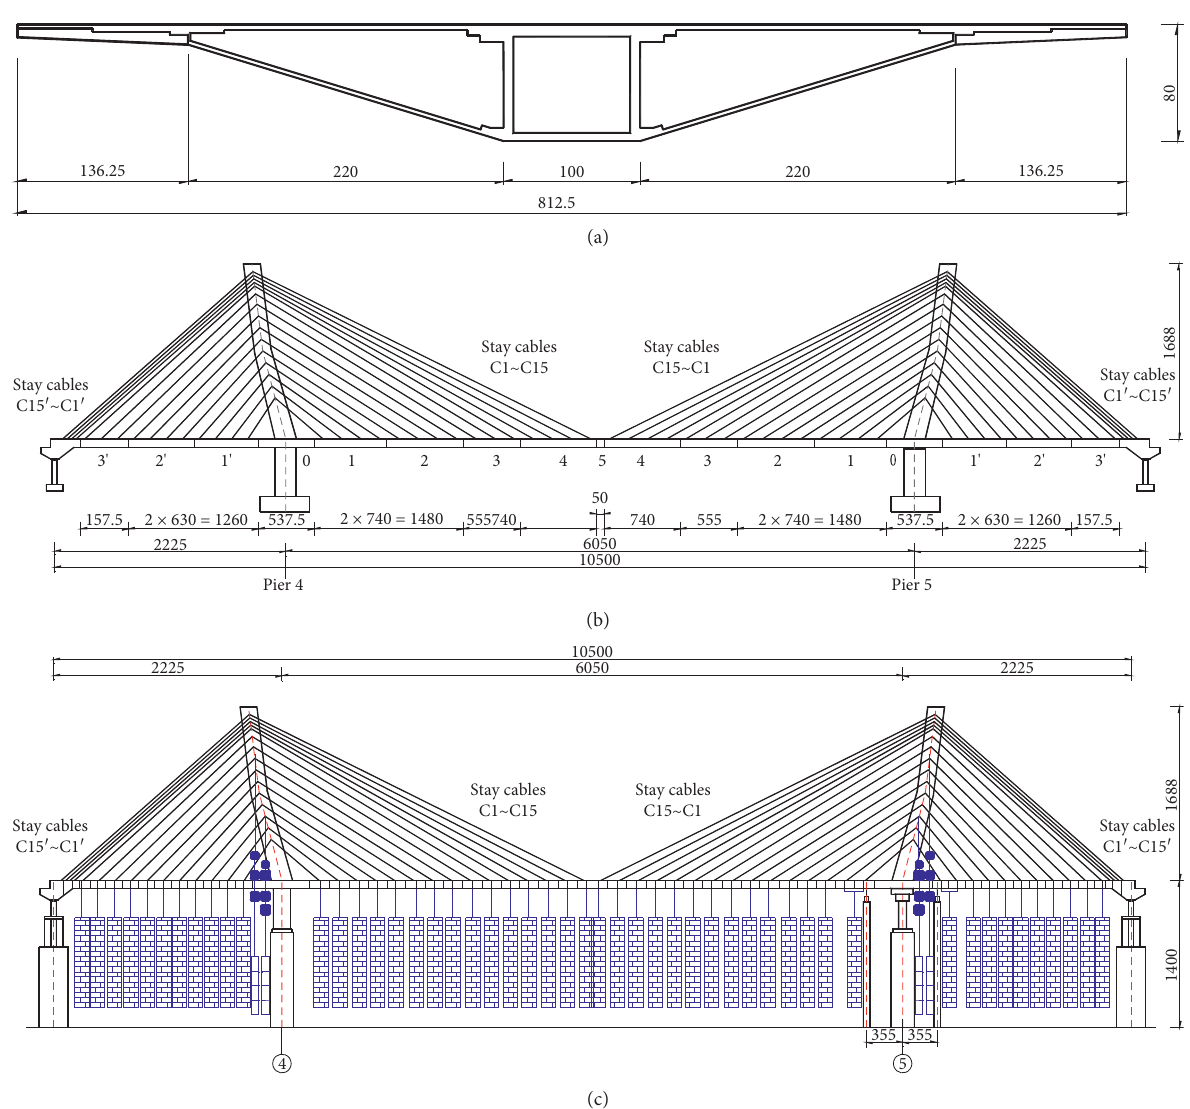
Figure 2: General arrangement drawing of model (unit: mm), (a) midspan section diagram, (b) block diagram, and (c) temporary support and loading